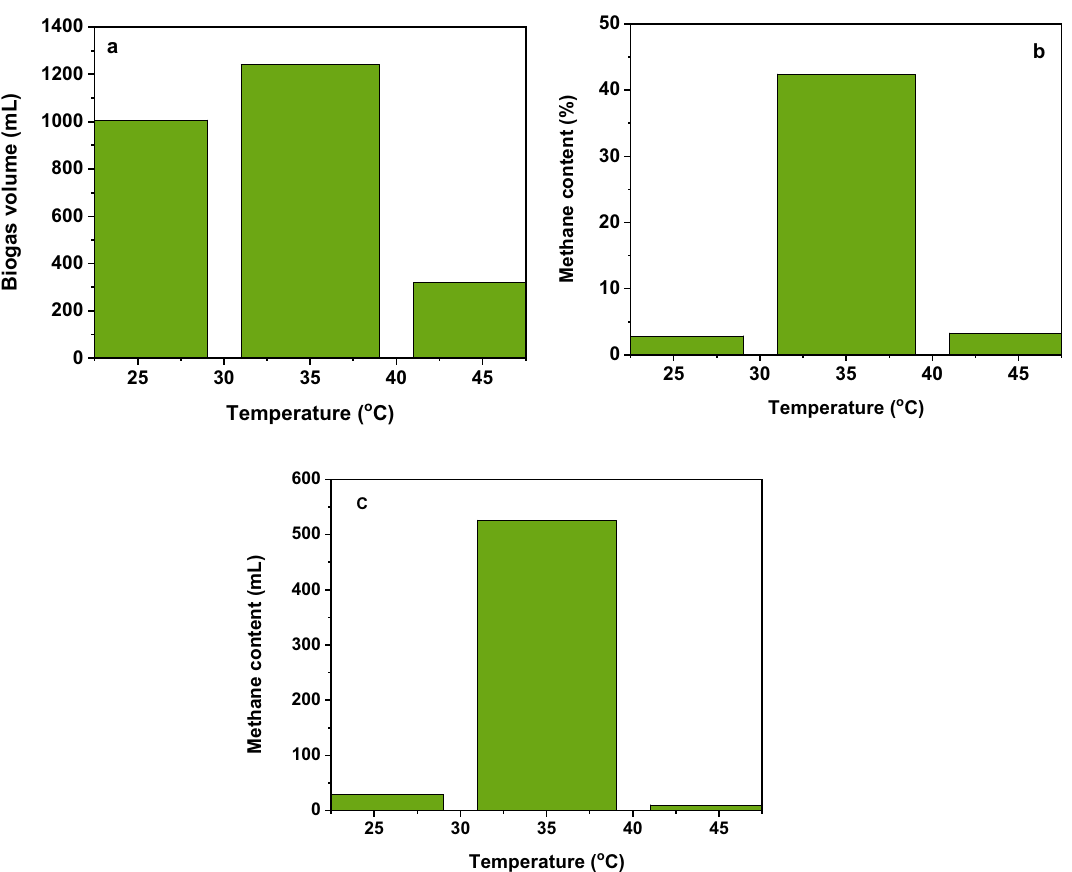
Figure 5. ( a ) Biogas production (mL) as a function of temperature, ( b ) methane content (%) as a function of temperature, and ( c ) methane content (mL) as a function of